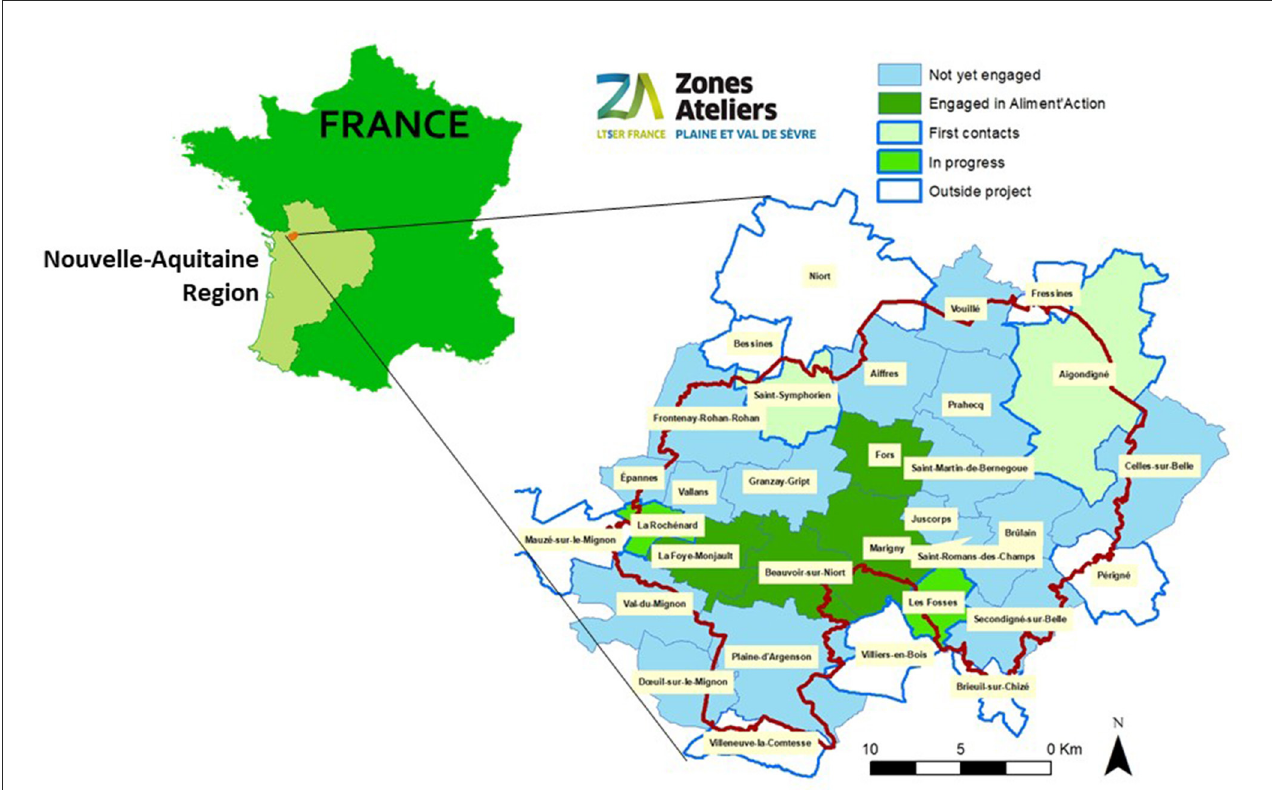
FIGURE3 Study area of the Aliment’Actions project. The figure highlights all municipalities that intersect with the Zone Atelier Plaine and Val de Sèvre (ZAPVS). Municipalities involved in the project (as of 2021) are indicated in green, while those not yet involved as of 2021 (but that will be within the 10-year project duration) are indicated in light blue. Municipalities usually include several villages, which means that the 24 municipalities actually encompass 40 villages in